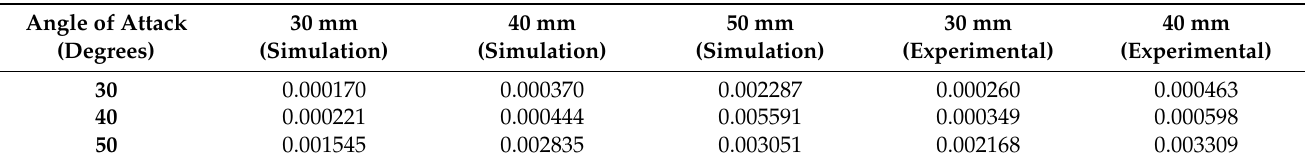
Table 4. Simulated and experimental values of lift coefficient of bullet heads of 30 mm, 40 mm, and 50 mm at varying angles of